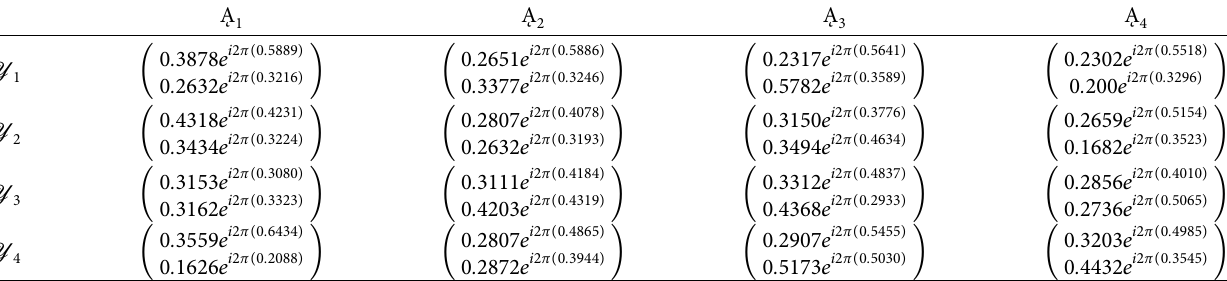
Table 5: Collective DM matrix using the CPFDMSM operator.